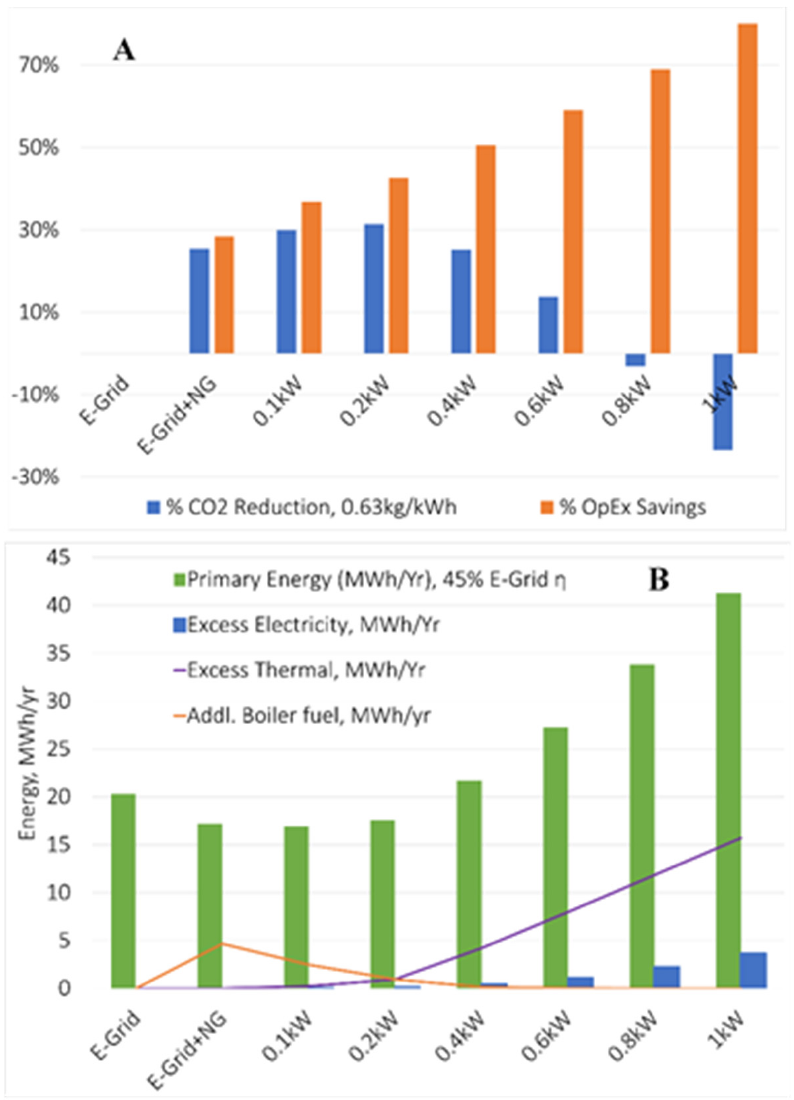
Figure 4. Impact of energy source configuration on carbon dioxide emissions, operational expendi- ture, primary energy consumption, heating fuel demand. ( A ) Reduction in CO 2 and operational expenses. ( B ) Total primary energy and additional heating fuel consumption. No PV in the cogen- eration system configuration.